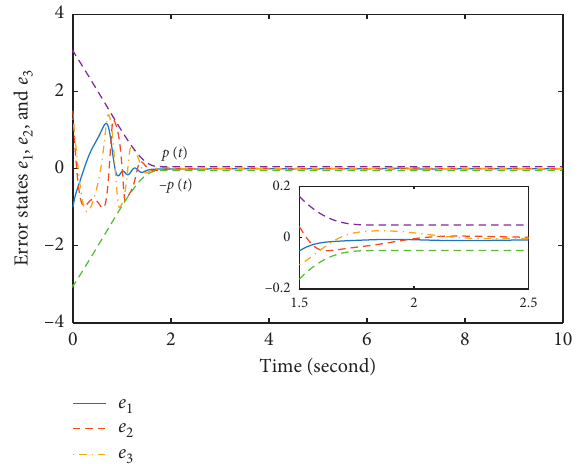
Figure 3: Trajectories of synchronization errors e � 2. t f